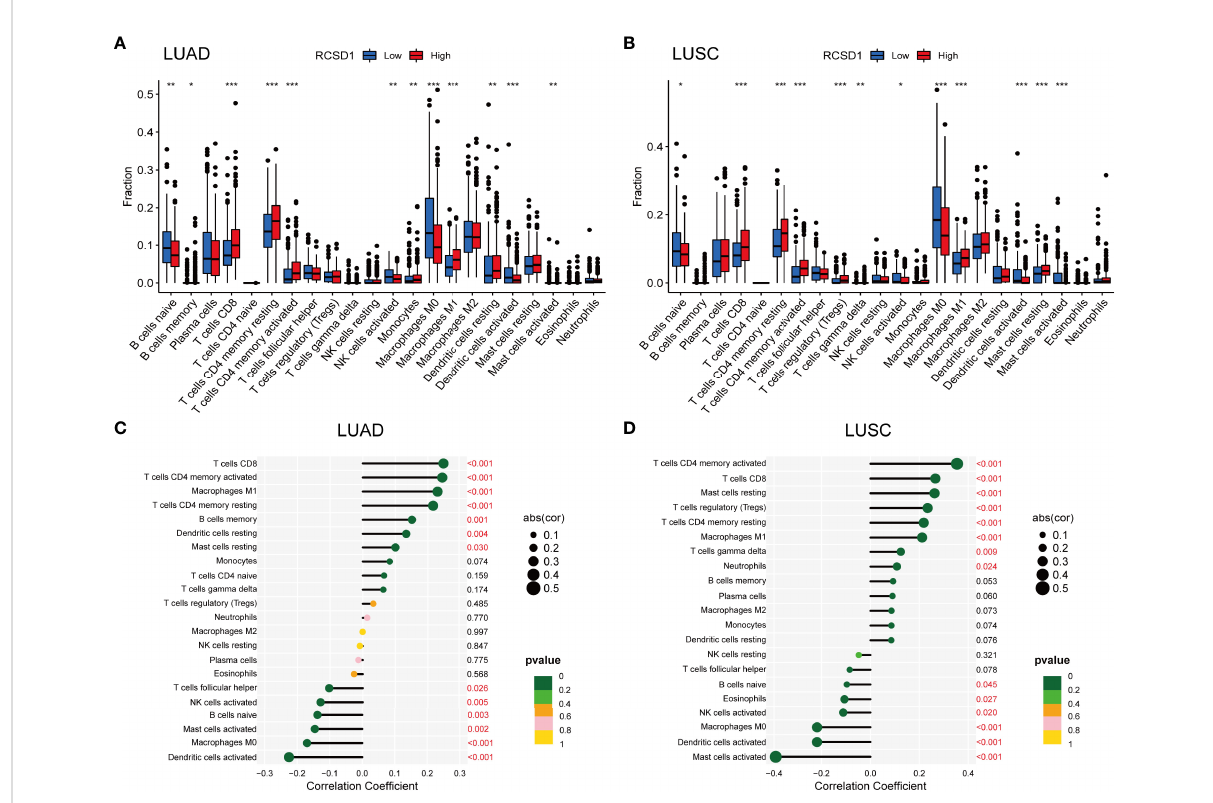
FIGURE 9 Relationship between RCSD1 and immune cells in LUAD and LUSC. The ratio of 22 immune cells in (A) LUAD and (B) LUSC tissues in the RCSD1 high and low expression groups. Correlation of RCSD1 and immune cells in (C) LUAD and (D) LUSC. *, P<0.05; **, P<0.01; ***,